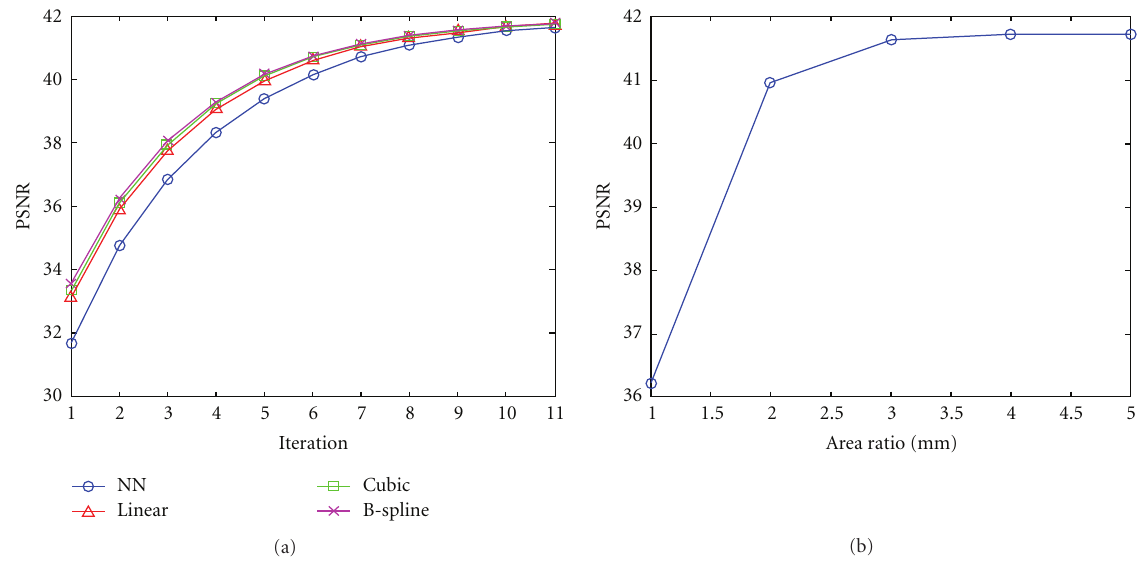
Figure 2: (a) E ff ect of initial interpolation method in the proposed method (all methods compared reached a similar stable result after 11 iterations). (b) PSNR values of the proposed method as a function of the radius of the search area. As can be noted, no significant improvement is found beyond that using a radius equal to 3. Table 1: PSNR values (larger values are better) of the di ff erent methods compared for several slices thicknesses for the normal brain anatomy case. Slice Thickness